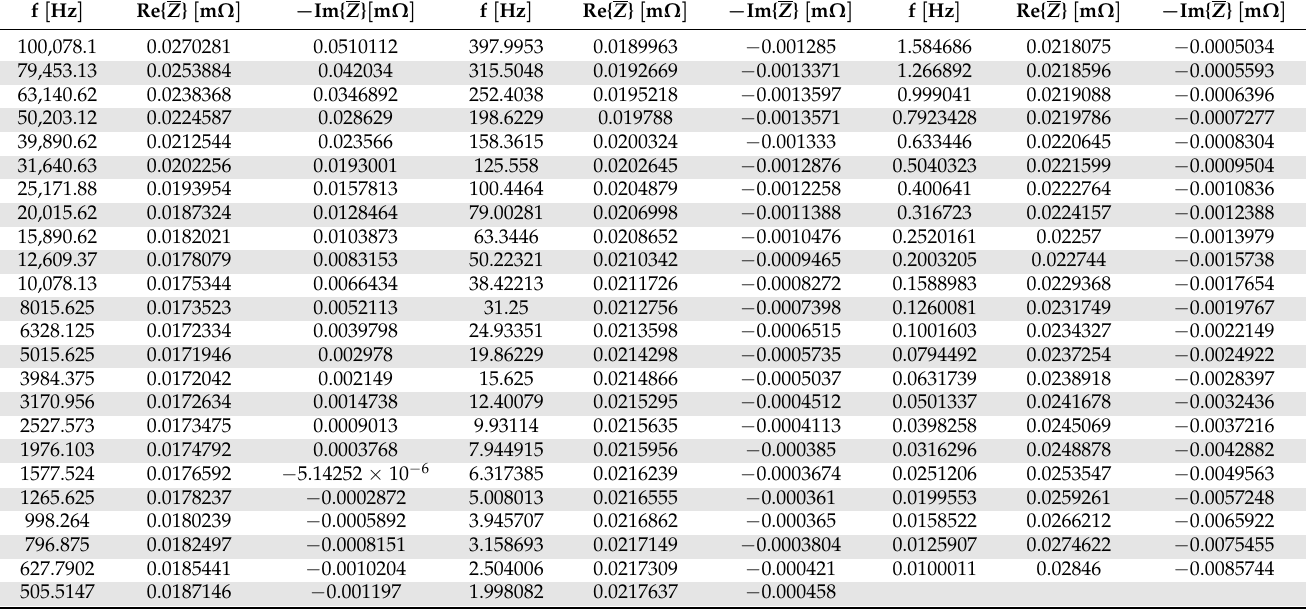
Table A3. EIS data for LG Chem HG2 at an SOC of